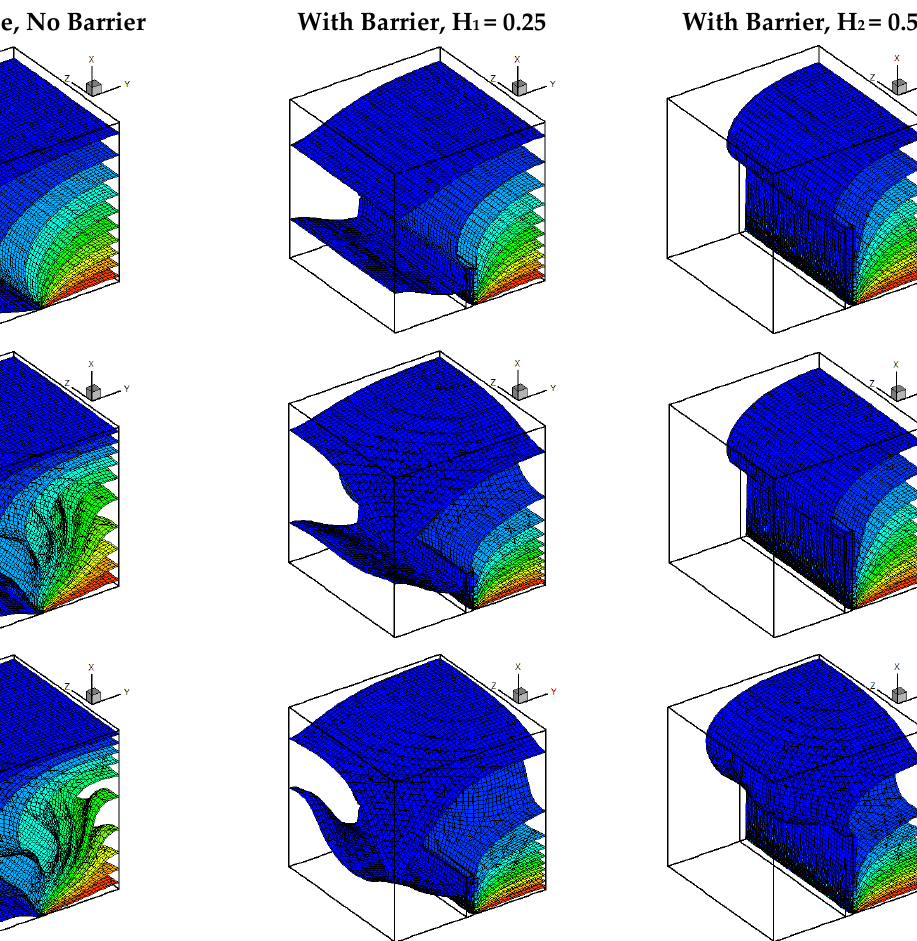
Figure 12. Contaminant iso-surfaces of concentration for different Ra, effect of two barriers’ heights for N = 0.2.